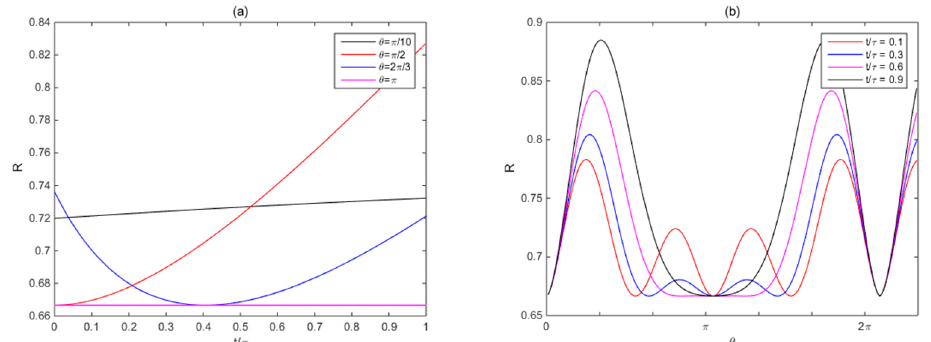
Figure 4. The ratio R temperature obtained before and after the application of the stimulated radiation pulse is shown as a function of ( a ) the time delay, wherein the lines each have pulse areas of π/10 , π/2 , 2π/3 , and π and ( b ) the pulse area, wherein the lines each have time delays of 0.1 𝜏 , 0.3 𝜏 , 0.6 𝜏 , and 0.9 𝜏 .